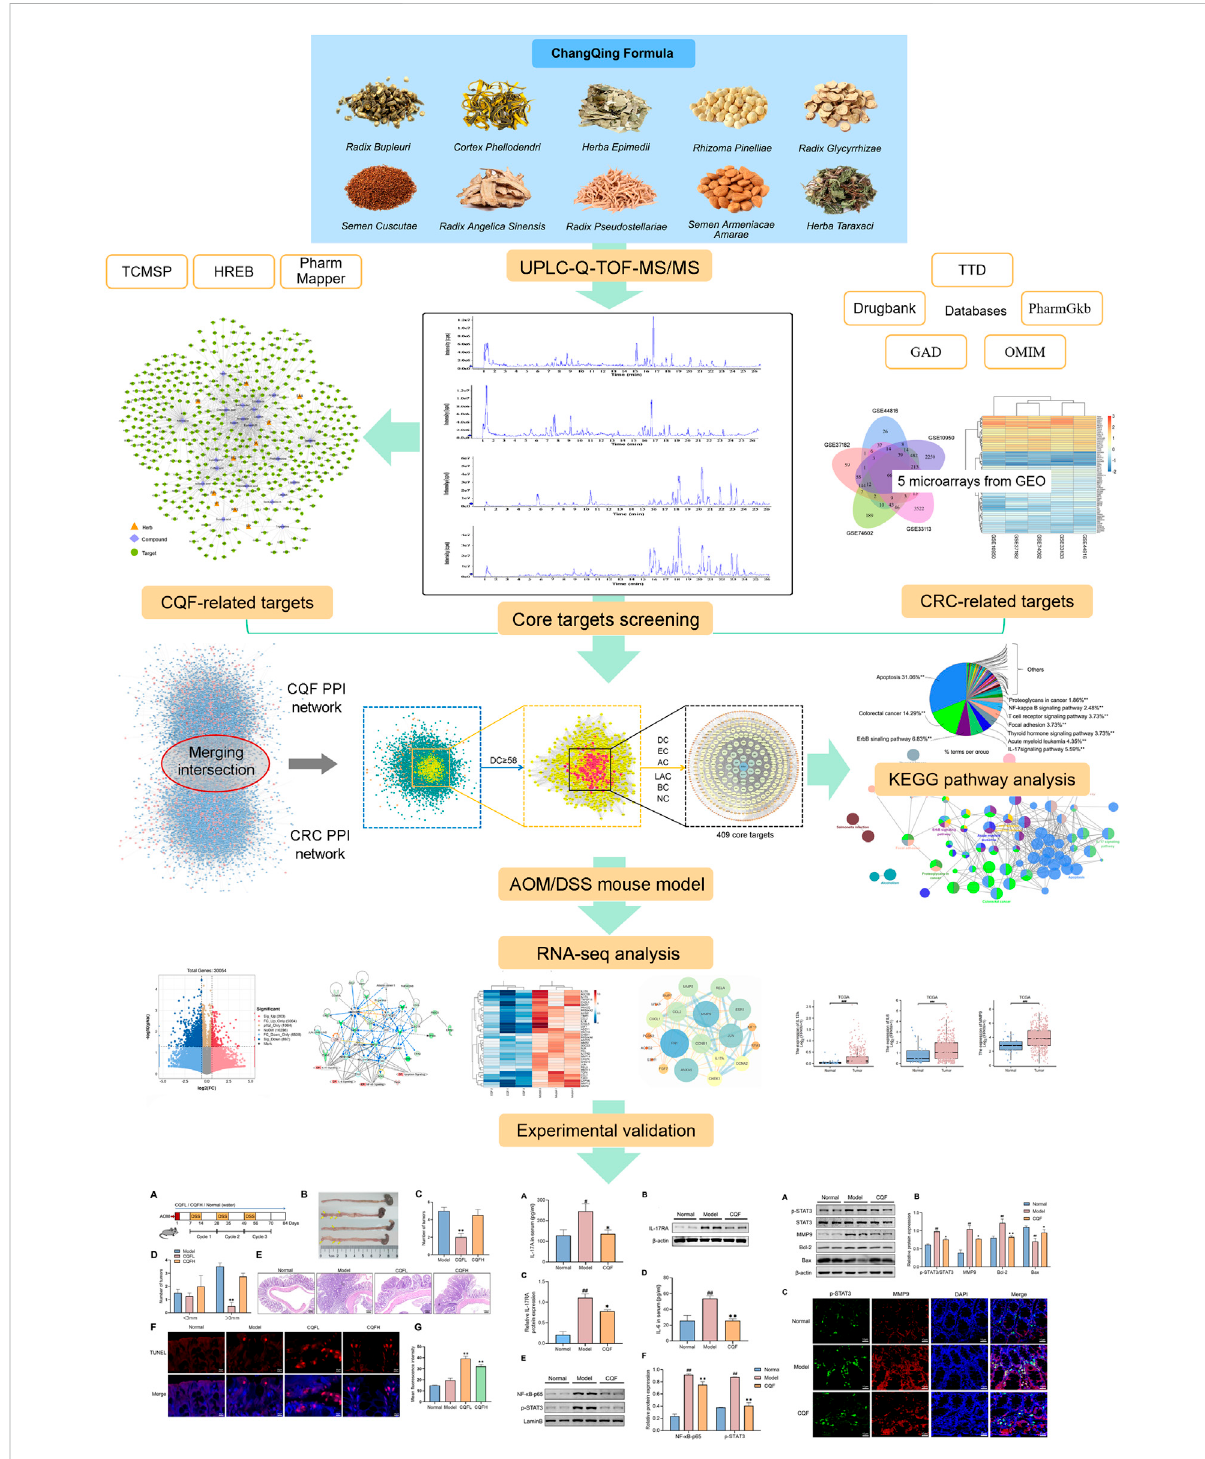
FIGURE 1 Overall fl ow of the study, assessing the effects of CQF in the treatment of CRC. All whole components of CQF and the components absorbed into bloodwereanalyzed byUPLC-Q-TOF-MS/MS.Componentsinblood components wereusedinnetwork pharmacology toconstructtheactive component-target network diagram screen for core genes affected by CQF in the treatment of CRC. Moreover, components in blood were used in bioinformatics enrichment analysis to identify KEGG signaling pathways affected by CQF. The effects of CQF were subsequently assessed in vivo utilizing a mouse model of AOM/DSS-induced